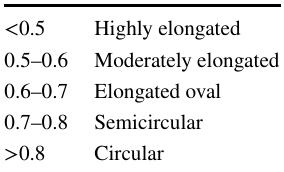
Table 4 Elongation ratio (Re) classification for different basin